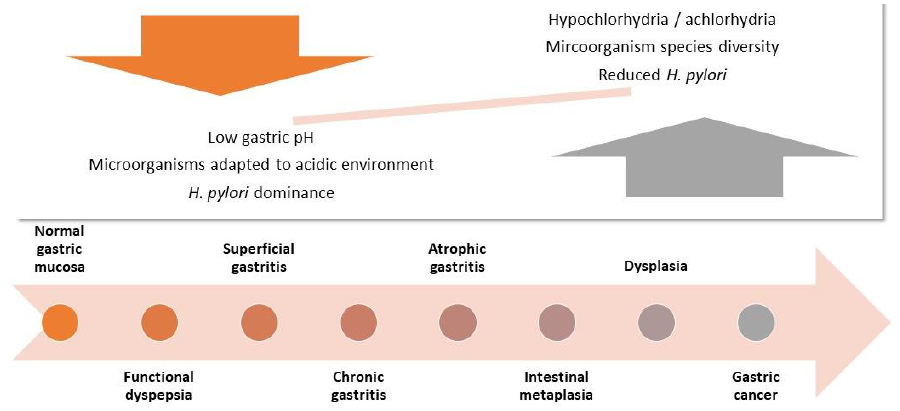
Figure 1. Changes in gastric microbiota and microenvironment during carcinogenesis (adapted from [11,13,16]). Following infection, H. pylori dominates the gastric microbiota leading to chronic gastritis, reduced acid secretion, and alterations in the gastric microbiome.